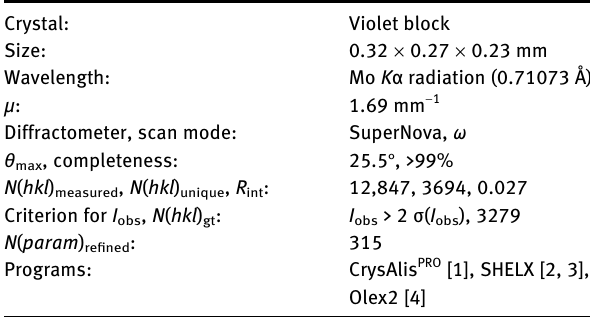
Table  : Data collection and